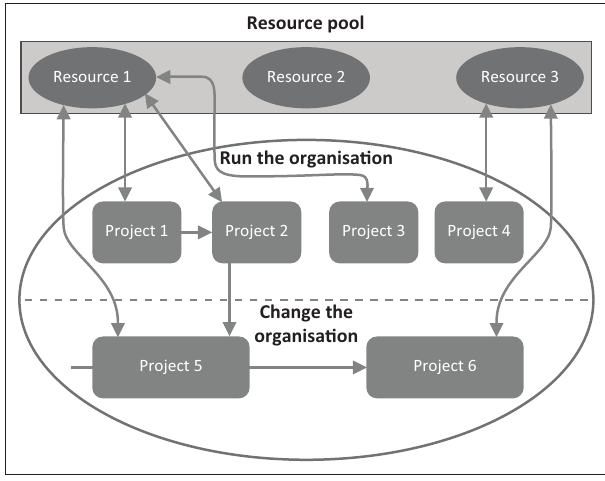
FIGURE 3: Illustration of the elements in the project